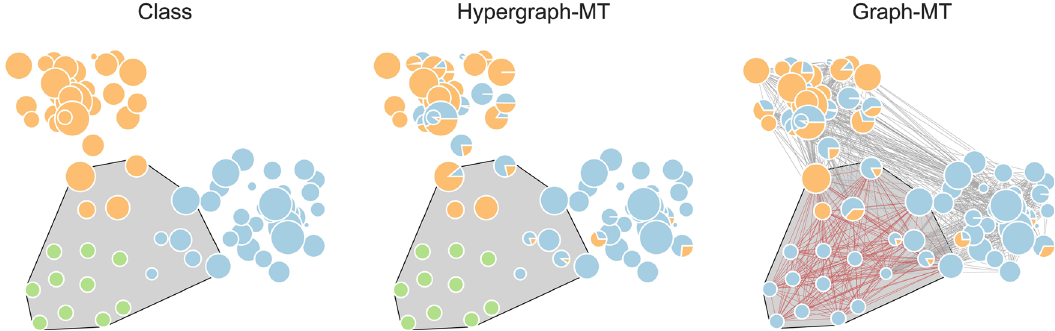
Fig. 1 | The advantage of hypergraph representation: an illustrative example. TheleftplotshowsasubsetoftheHighschooldataset,withnodesbelongingtothe classes2BIO1(lightblue)andMP*2(orange),andtenexternalguests(green).Node size is proportional to the degree. The gray hyperedgesimulates anevent, and we omit the other hyperedges for visualization clarity. The central plot displays the partition extracted by Hypergraph-MT and on the right we fi nd the partition